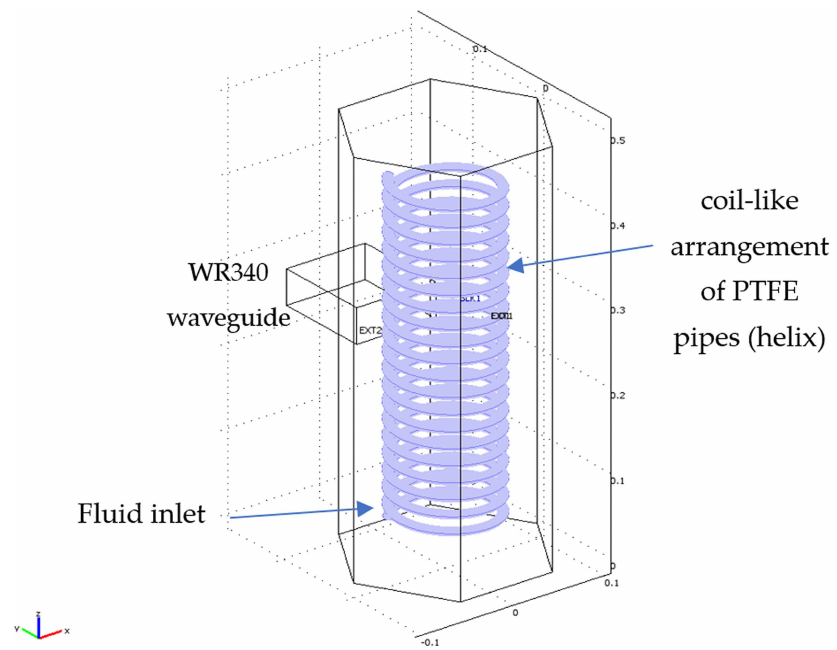
Figure 2. Geometry of the heating stage chamber of the microwave applicator.